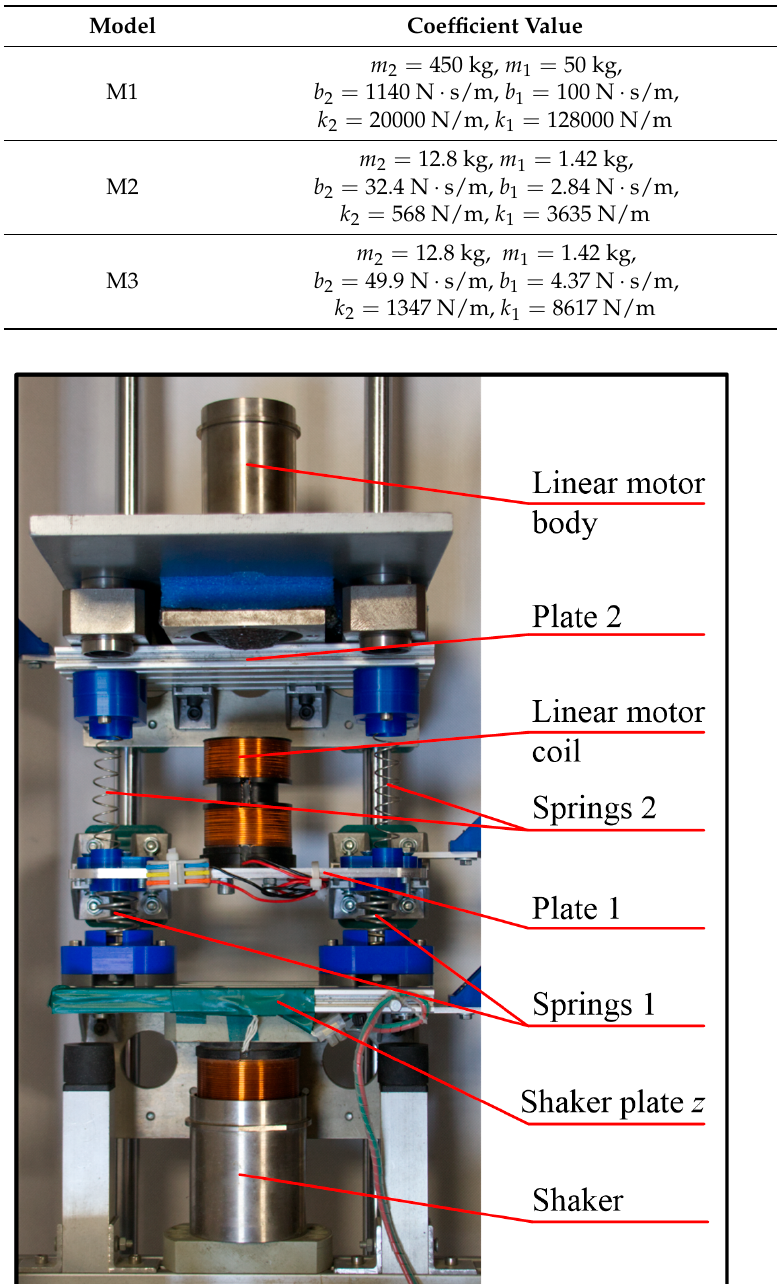
Table 1. Assumed model parameters.